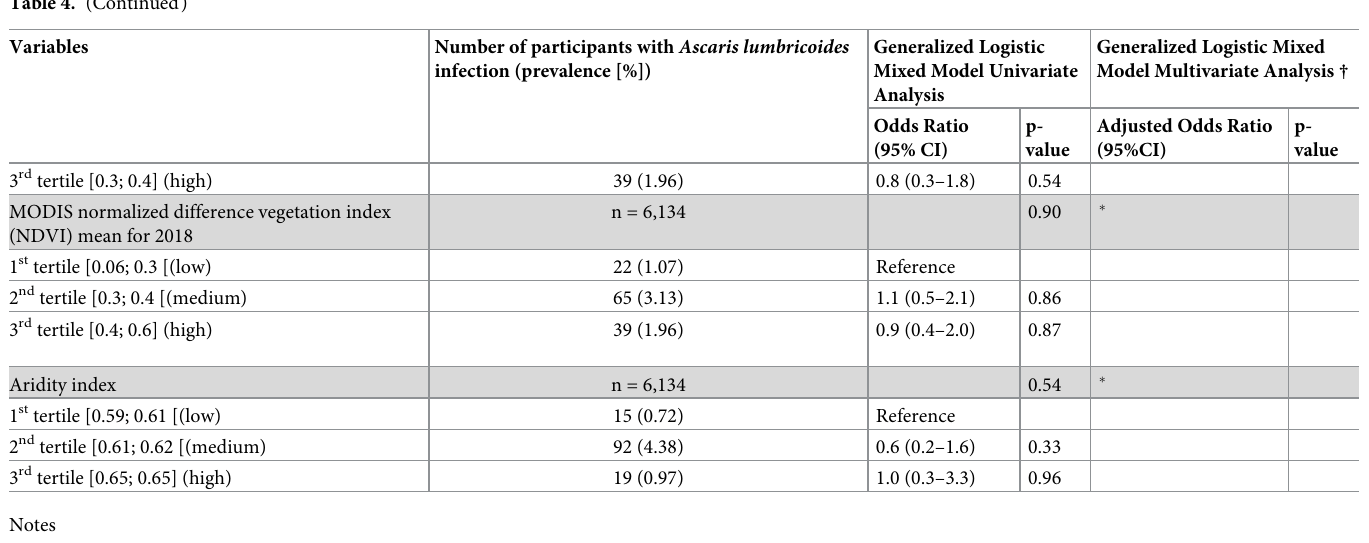
† Adjusted Generalized logistic mixed model estimating equations with exchangeable correlation structure. � Variable dropped from fully adjusted model during model adjustment process using lowest AIC criteria.